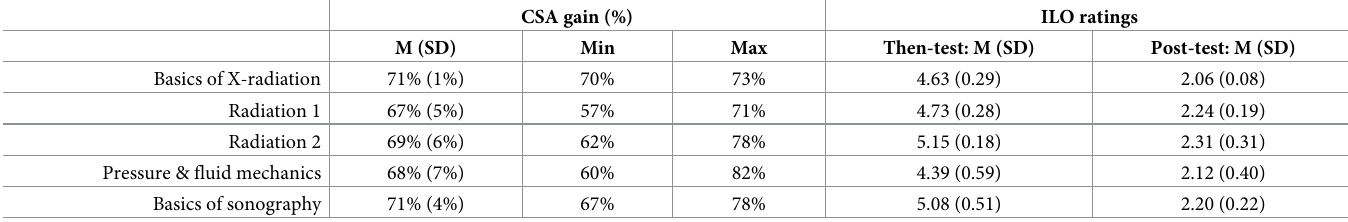
Table 3. Comparative self-assessment gains and intended learning outcomes ratings at then- and post-test of five different physics integrated supportive science